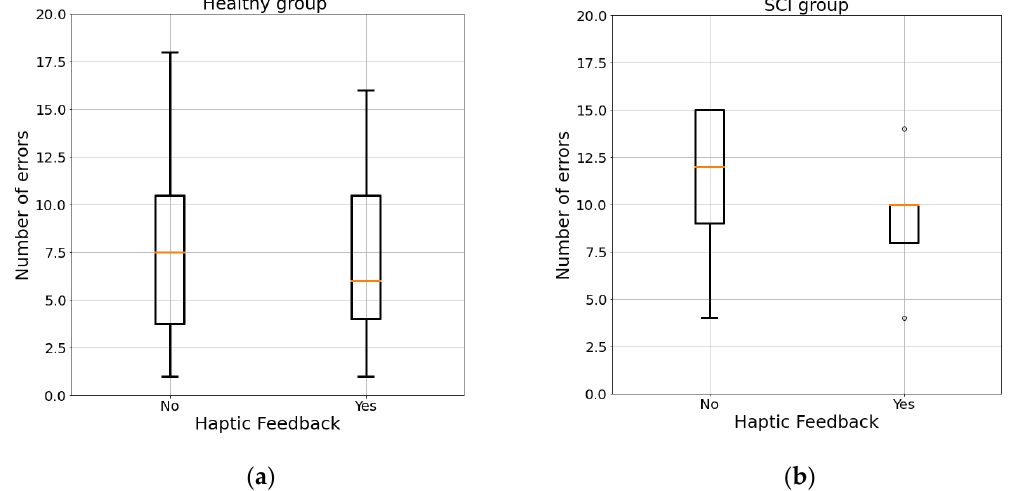
Figure 8. Boxplot comparison of the number of errors for the Path game with and without haptic feedback for ( a ) healthy subjects and ( b ) SCI patients.